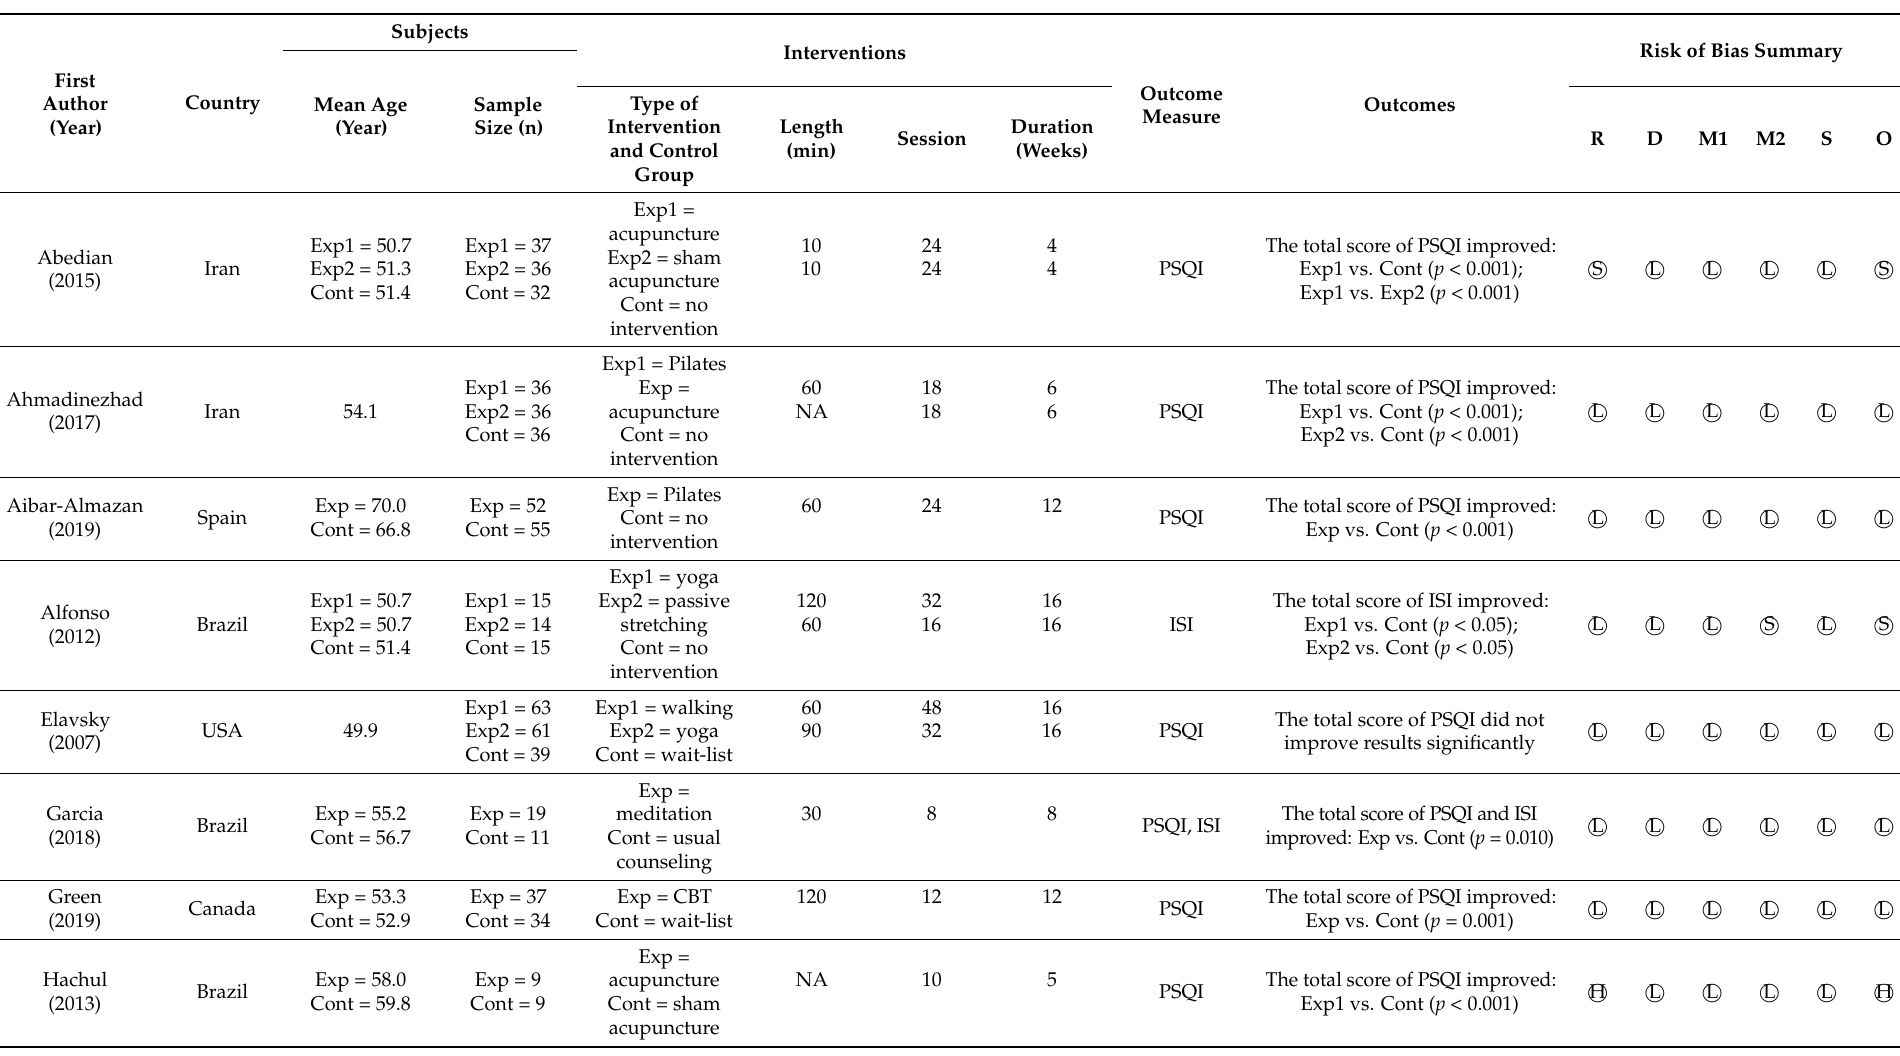
Table 1. Characteristics of included